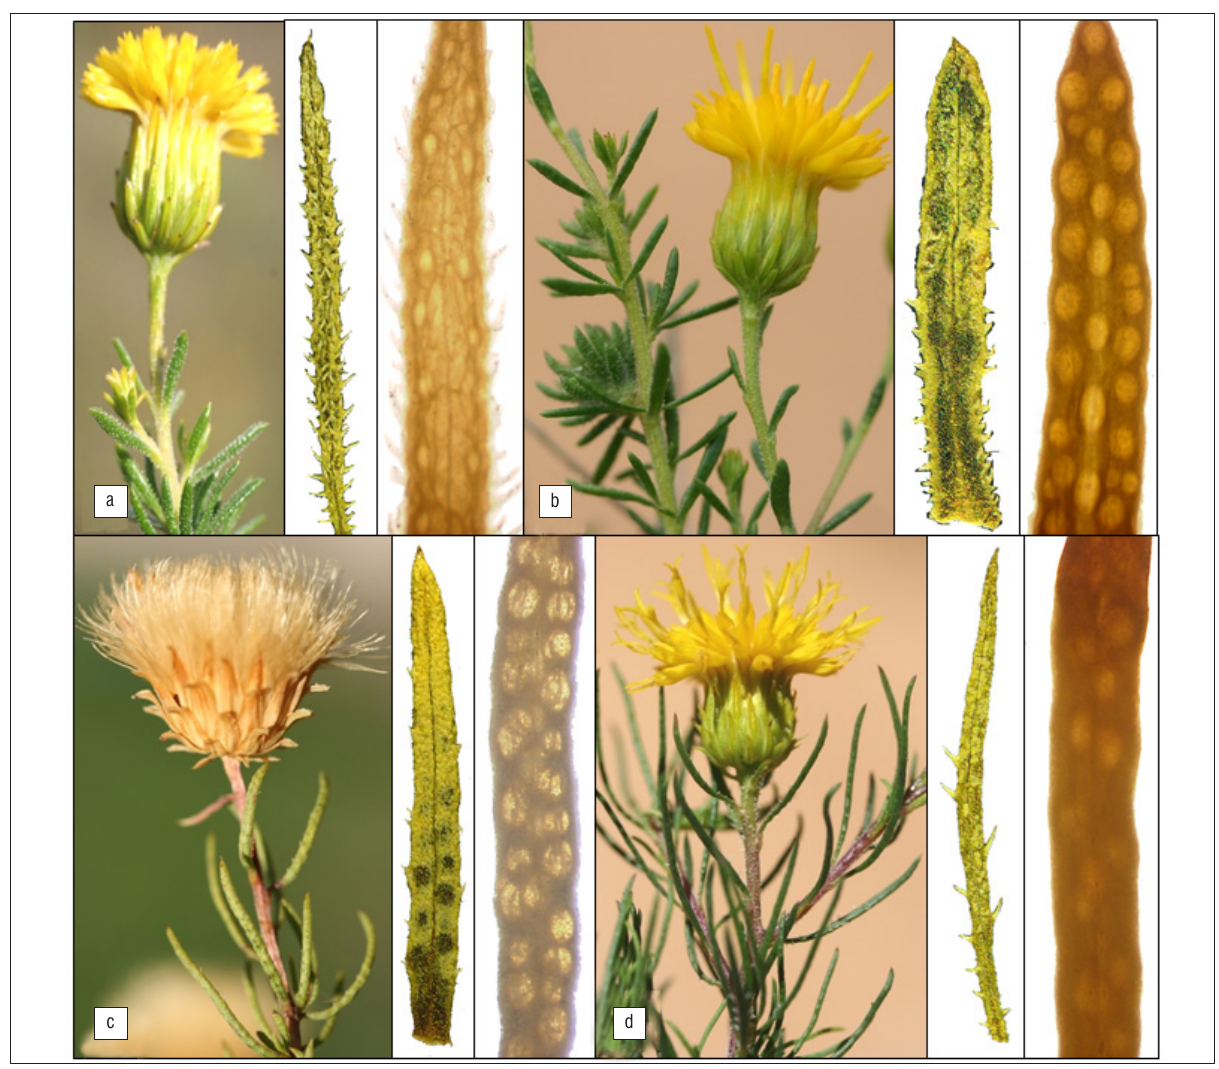
Figure 1: The morphology of flower-heads and leaves of four varieties of Pteronia camphorata. Specimens were (a) P. camphorata var. armata at Kleinvlei near Wupperthal, (b) P. camphorata var. camphorata at Dasklip Pass near Porterville, (c) P. camphorata var. laevigata at Nieuwoudtville, and (d) P. camphorata var. longifolia from Paarl Mountain. Note the distribution of cilia on leaves and presence of translucent oil glands. Photographs